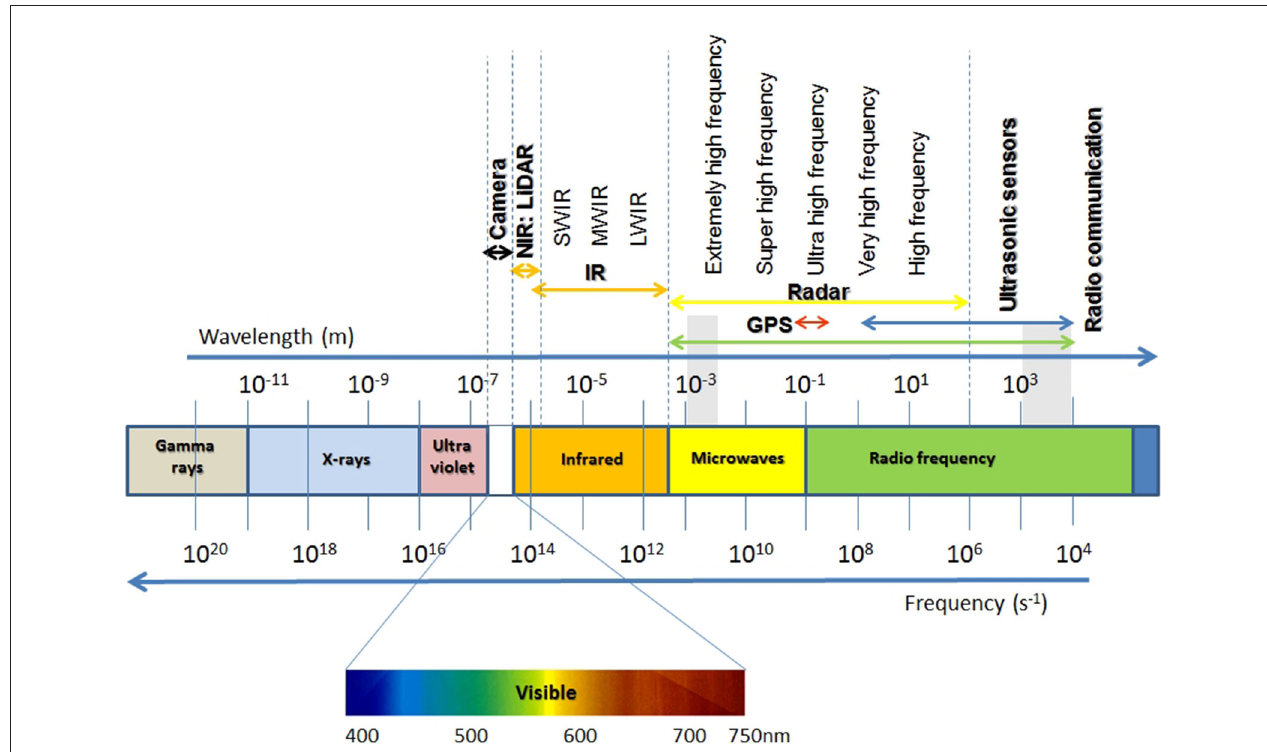
FIGURE 9 | Electromagnetic spectrum: a better understanding of the operating range of each type of information sources used in CAV development.